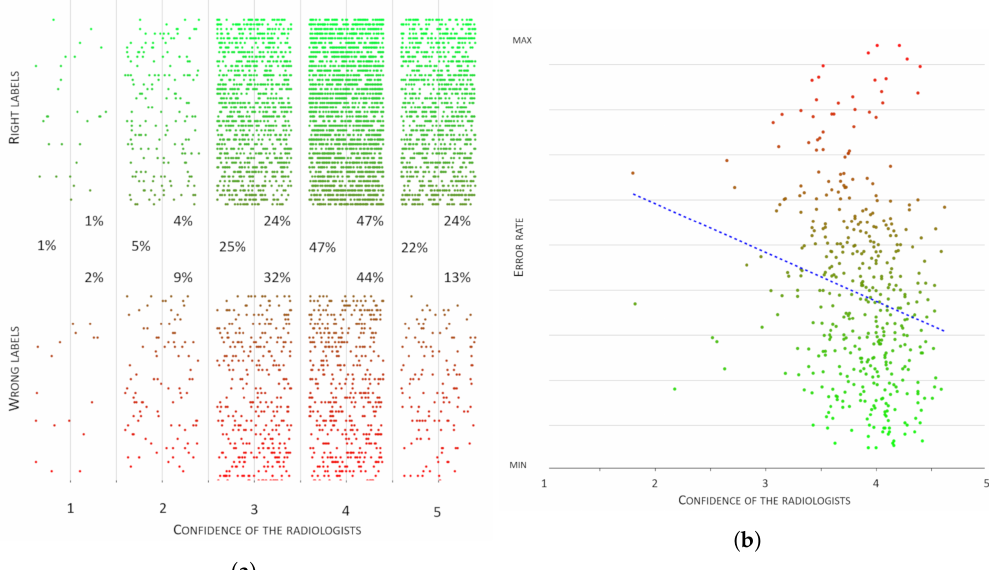
Figure 8. Results in graphical format: ( a ) The distribution of the labels in terms of right/wrong annotation, with respect to the confidence levels. For each confidence level, the percentages in the left column indicate the confidence level proportion with respect to all the cases; the top and bottom percentages in the right column indicate the proportions of right (resp. wrong) labels in the corresponding confidence level. ( b ) Relationship between the raters’ confidence and the probability of error; the regression line suggests a mild inverse